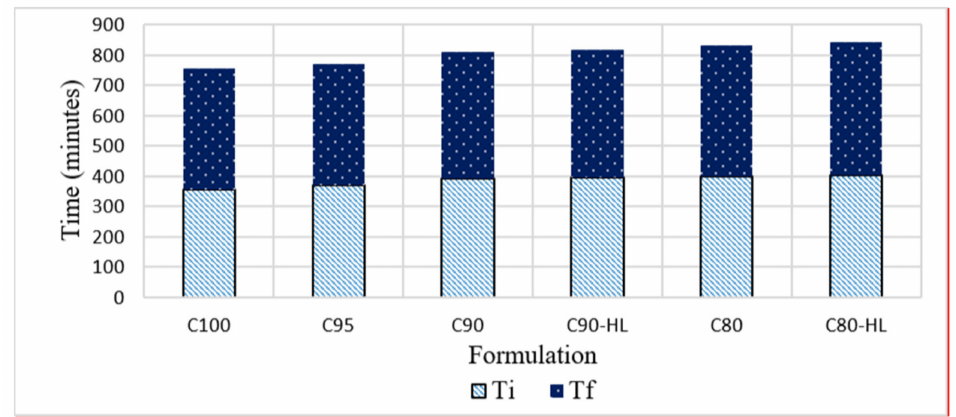
Figure 9. Effect of waste burnt brick powder on setting time (Ti = initial set, Tf = final set) of self-compacting paste